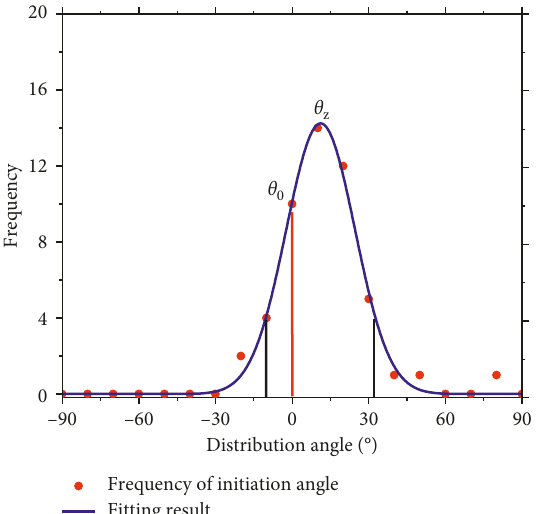
Figure 10: Statistical result of initiation